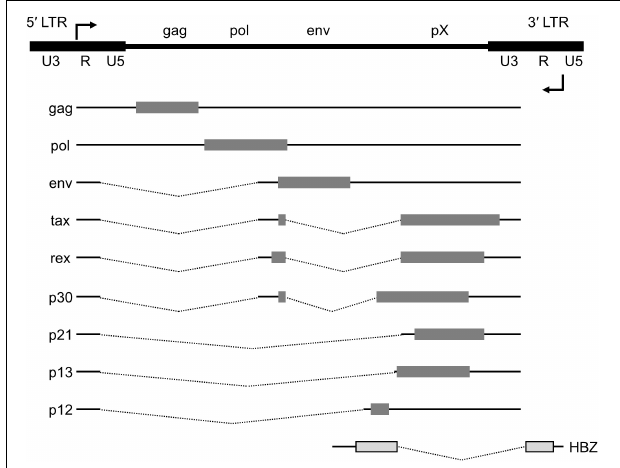
FIGURE 1 | Genome structure of the HTLV-1 provirus. The proviral DNA with the LTRs and viral transcripts encoded in either the plus or minus strand of the viral genome. Alternative splicing yields doubly spliced (tax, rex and p30), singly spliced (env, p21, p13, and p12) mRNAs as well as the unspliced gag and pol transcript. The structural genes (gag, pol and env) and the pX region are flanked by the 5 (cid:48) and 3 (cid:48) LTRs. HBZ, encoded on the minus strand, is transcribed from the 3 (cid:48)